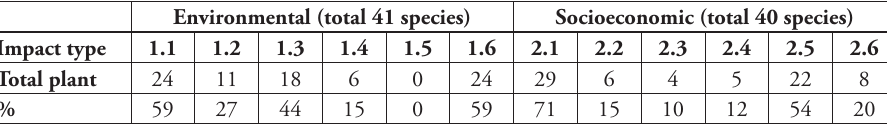
Table 3. Overview of categories scored in the two impact groups (environmental and socioeconomic), numbers of alien species for which the data were found, and % of the 51 species screened. The numbers of scored species in categories include also zero